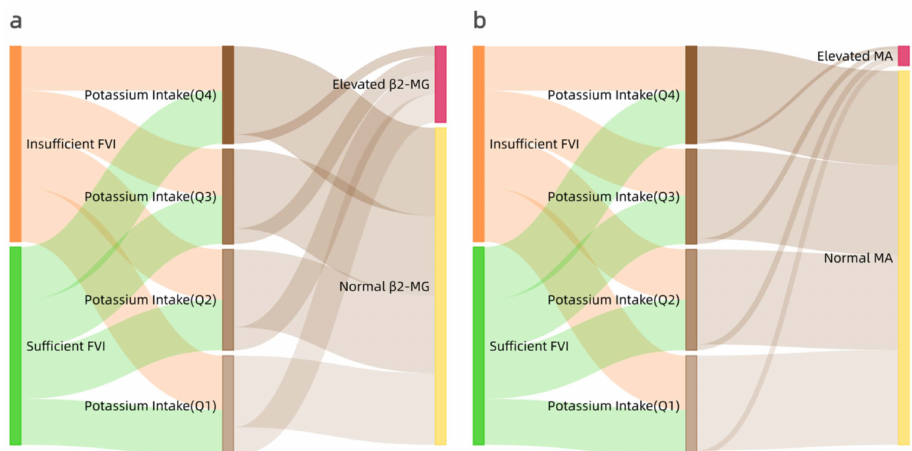
Figure 2. Sankey diagrams of renal damage with estimated potassium intake; elevated β 2 -MG ( a ) or elevated MA ( b ) urinary excretion were more likely to originate from lower quantile of potassium